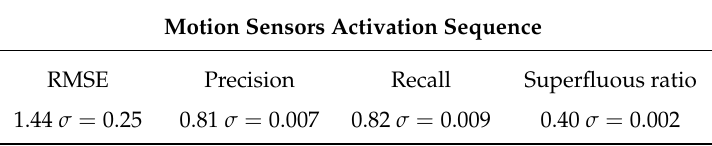
Table 5. SAS analysis for motion sensors with W = 7